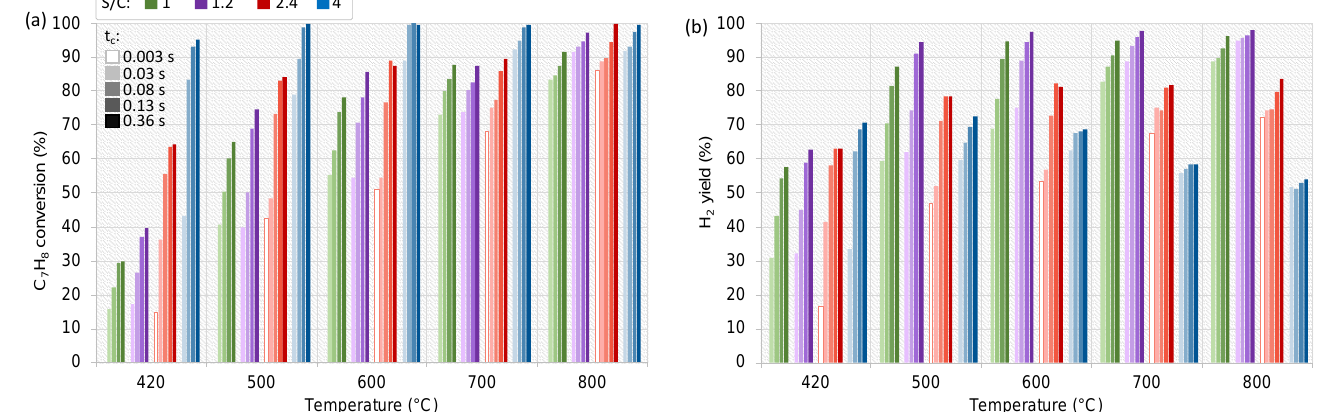
Figure 7. The influence of contact time (t c ) on C 7 H 8 conversion ( a ) and H 2 yield ( b ) vs. temperature during the catalytic runs of SRT carried out in stationary conditions with the S/C ratios of 1 (green), 1.2 (purple), 2.4 (red), and 4 (blue). The darker the shade of the bar, the higher the t c value.